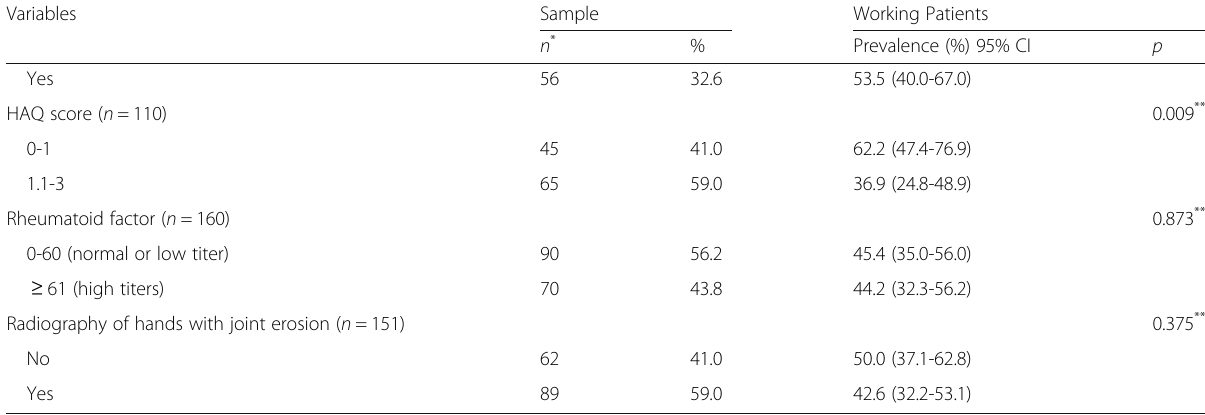
Table 1 Description of the sample and of the prevalence of working patients with rheumatoid arthritis in Blumenau, Santa Catarina state, Brazil, according to the independent variables, 2014